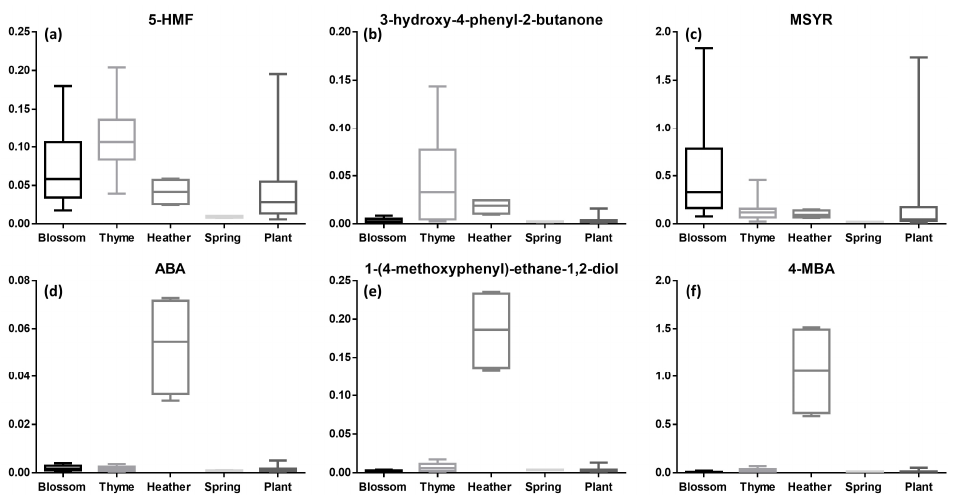
Figure 4. Box plots of statistically significant biomarkers based on their botanical origin are presented. ( a ) 5-HMF, ( b ) 3-hydroxy-4-phenyl-2-butanone, ( c ) MSYR, ( d ) ABA, ( e ) 1-(4-methoxyphenyl)-ethane- 1,2-diol and ( f ) 4-methoxybenzoic acid. All p -values can be found in Table